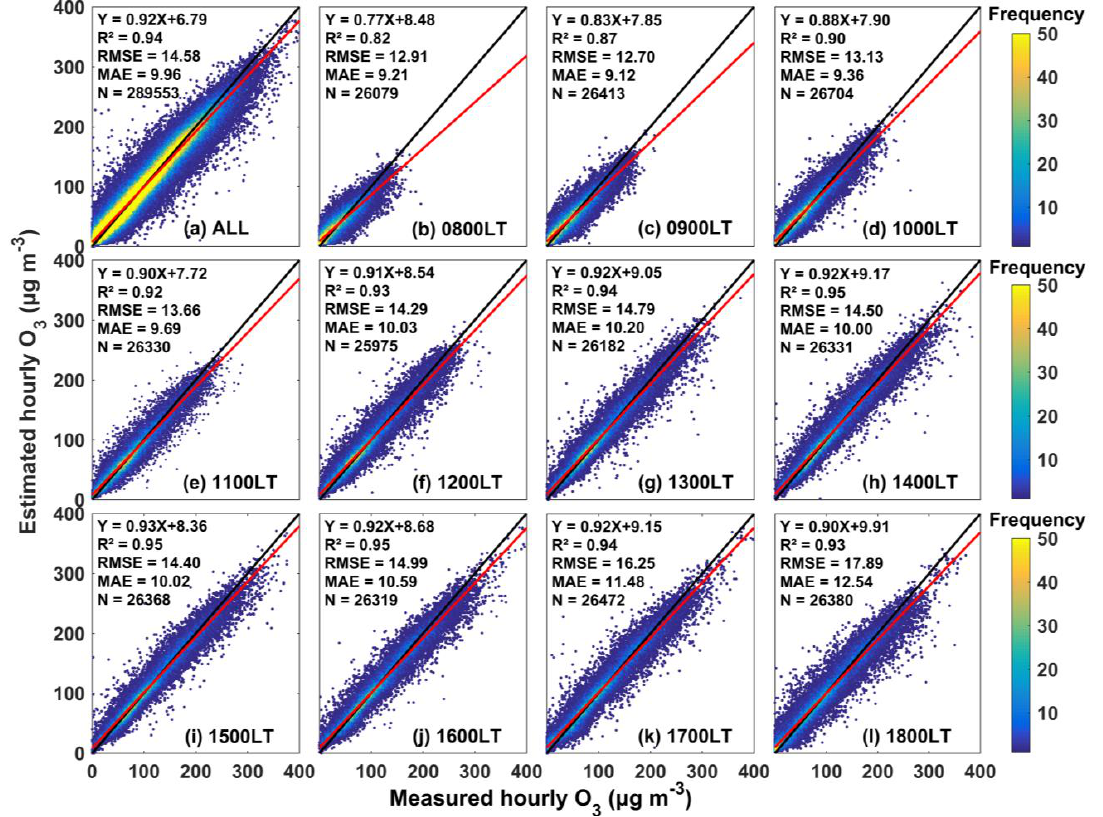
Figure 2. Density scatter plots of the sample-based 10-CV results from 08:00 local time (0800 LT) to 18:00 local time (1800 LT) across the BTH region in 2018: ( a ) all hourly records from 0800 to 1800 LT; and ( b – l ) sample-based 10-CV values for each hour from 0800 to 1800 LT. The black lines denote 1:1 lines and the red lines denote linear regression fitting